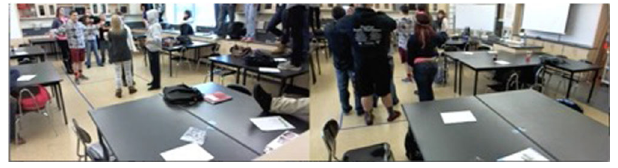
FIG. 3. Snapshot illustrating split-screen video capture. For perspective, the right camera is placed behind students in the background of the left